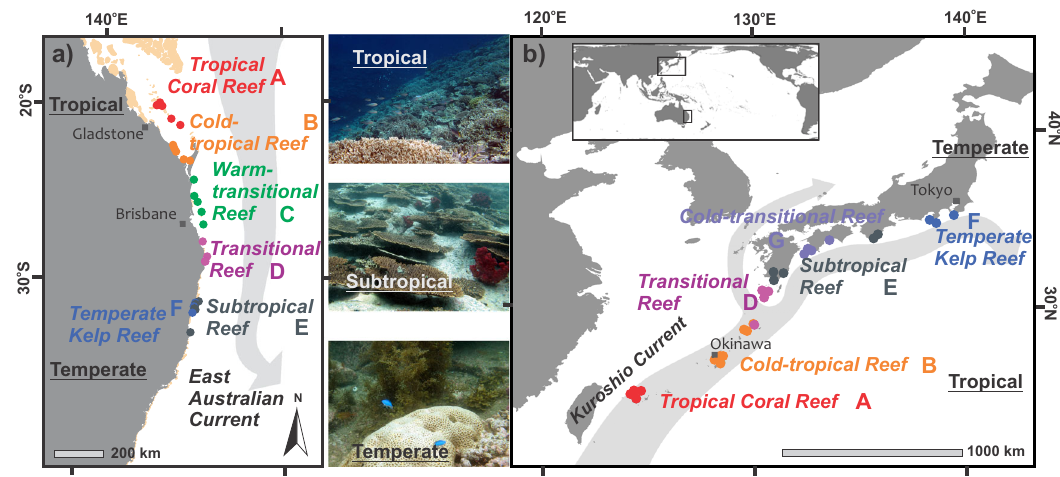
Fig. 1 | Map of tropicalising reef zones. Survey sites (dots) grouped into transi- tional community zones (coloured text, for analysis of environmental space, see Supplementary Fig. S1) using fi sh biomass in: ( a ) Australia and ( b ) Japan. Peach